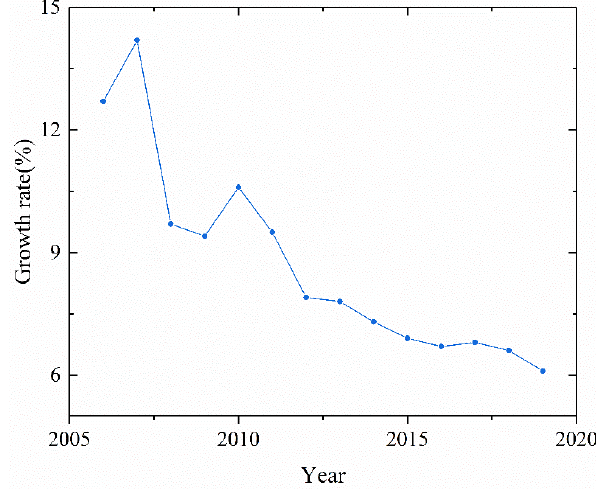
Figure 2. GDP growth rate in China.